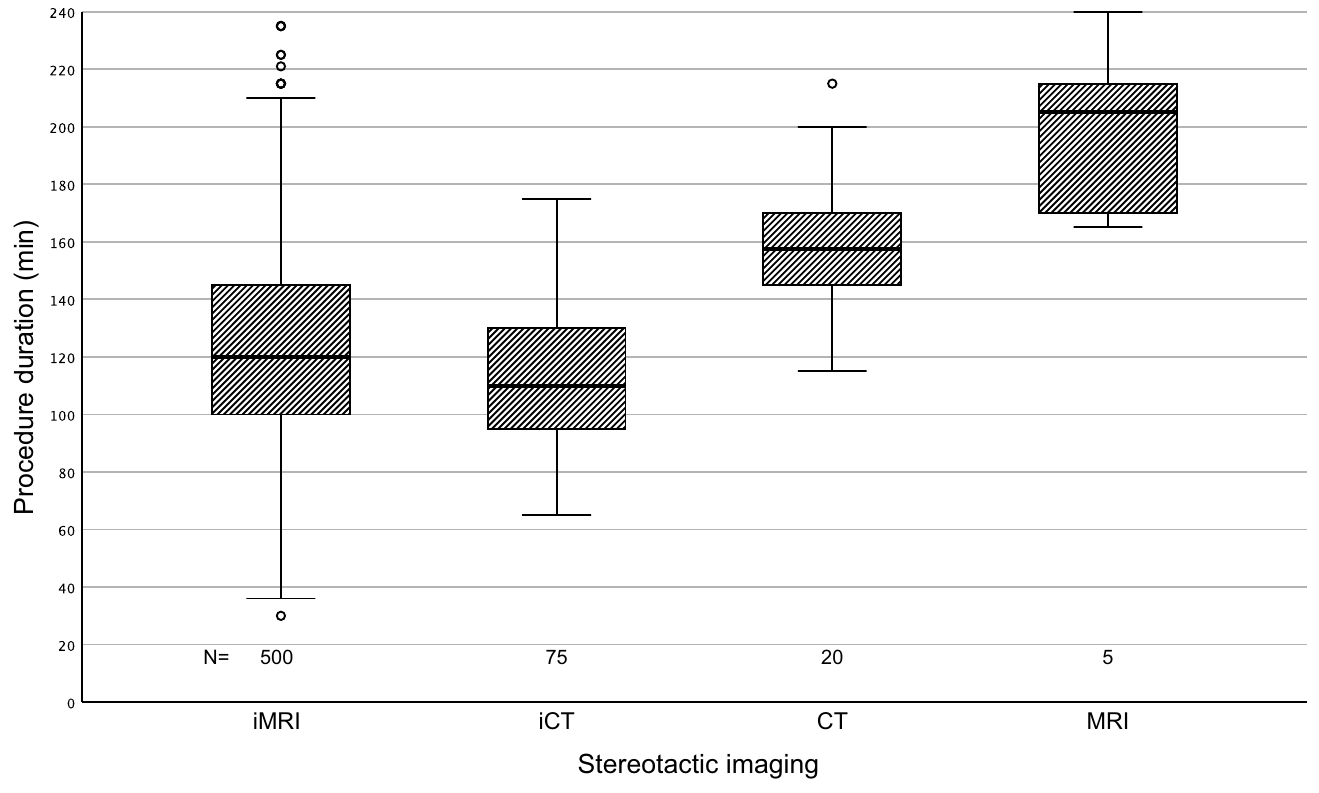
Fig 3. Procedure duration stratified by imaging modality. The duration of the procedures (time spent in the stereotactic frame) was significantly influenced by the imaging modality used to acquire the stereotactic dataset (One-way ANOVA, p < .000). Post-hoc testing (LSD-Bonferroni) showed significant differences between each individual imaging modality with exception of the CT/MRI pair. Procedures performed with intraoperative CT (iCT) required the least amount of time (median 110 min) followed by iMRI-based biopsies in second place (median 120 min). Imaging performed outside the OR (CT and MRI) considerably increased overall procedure time.